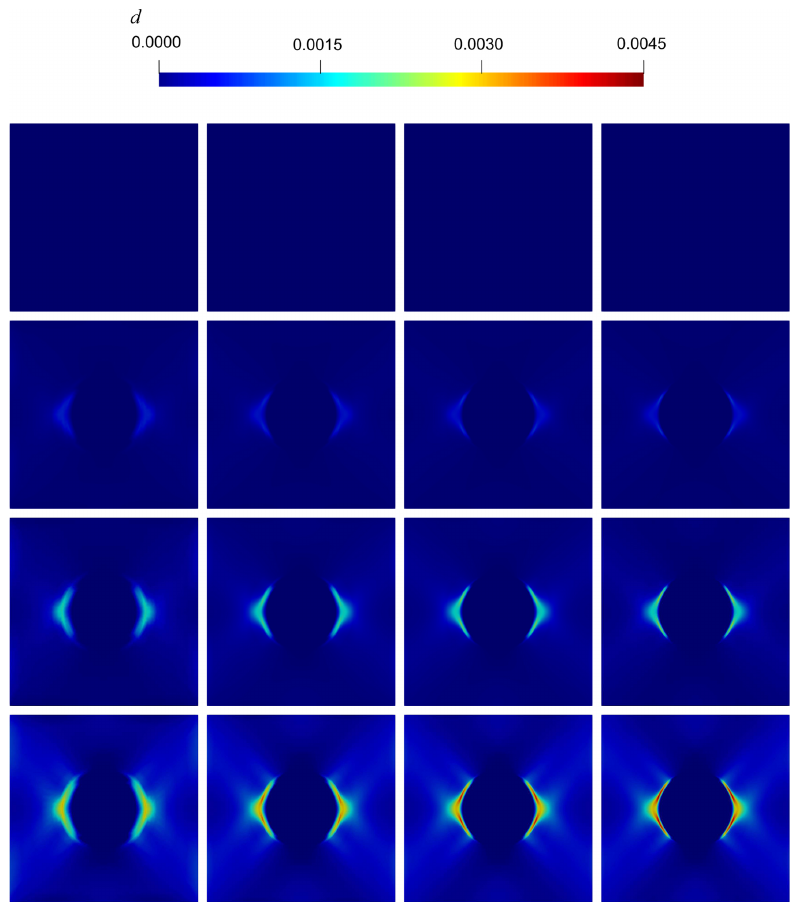
Figure 4: Tension: distribution of damage 𝑑 for 1024, 3136, 6400 and 10,816 elements (from left to right) for steps 200, 245, 255 and 270